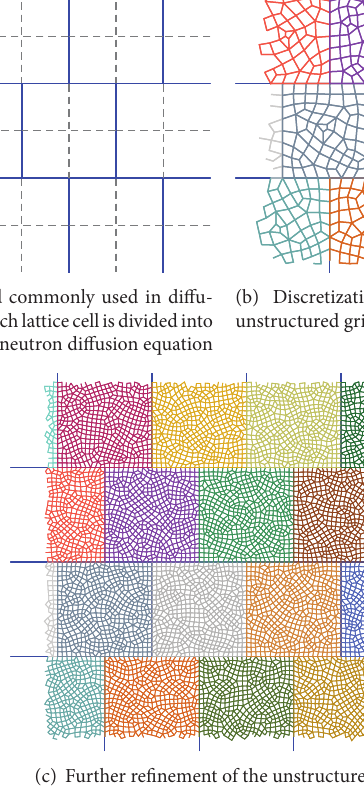
Figure 1: Discretization of a homogenized PHWR array of fuel channels for a core-level diffusion computation. Each square is a lattice-level cell comprising one fuel channel and the surrounding